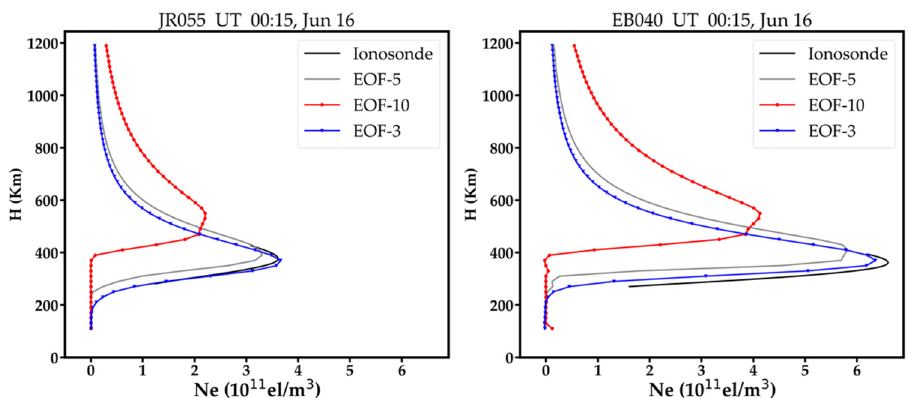
Figure 14. Vertical profiles obtained by the BCDC model using three (EOF-3), five (EOF-5) and ten (EOF-10) EOFs at EB040 and JR055 at 00:15 LT on June 25,